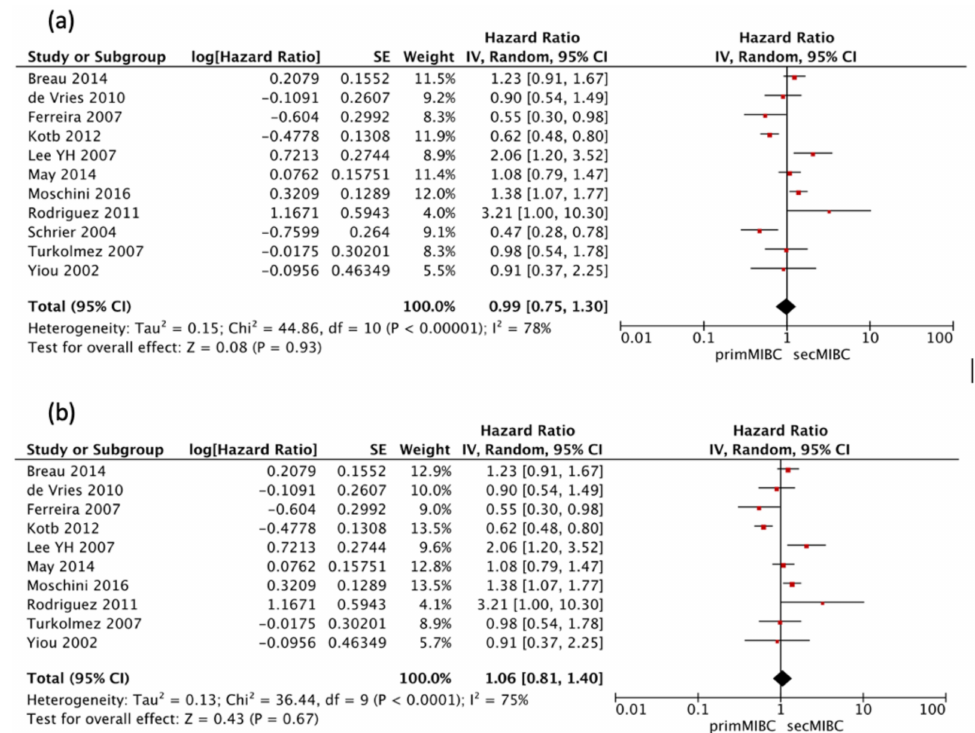
Figure 4. ( a ) Forest Plot for 10-year CSS according to starting point of follow-up, ( b ) Forest Plot for 10-year CSS after